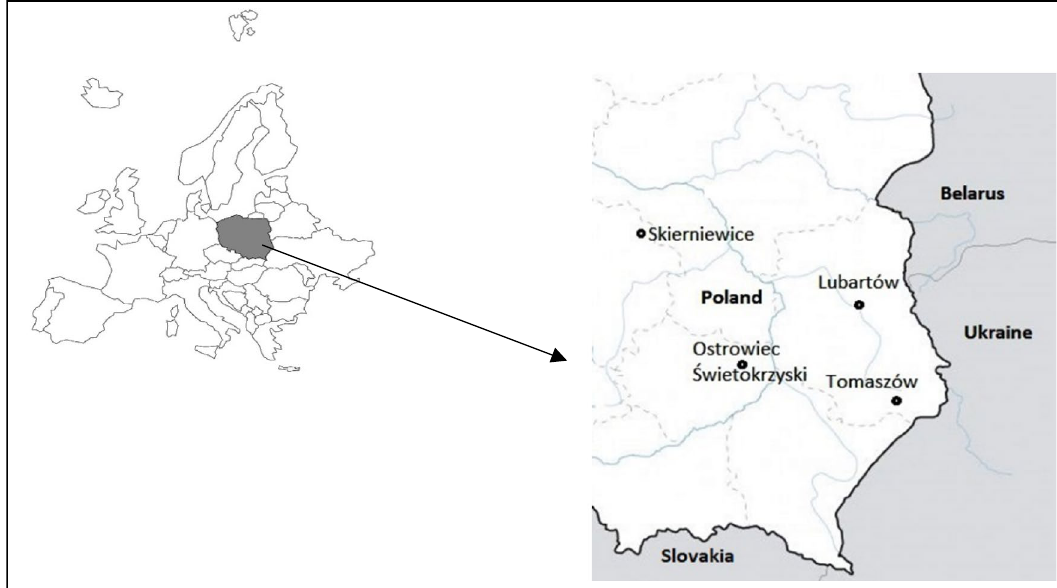
Figure 1. Areas of harvesting pheasants. Generated by the authors using CorelDRAW Graphics Suite 2023